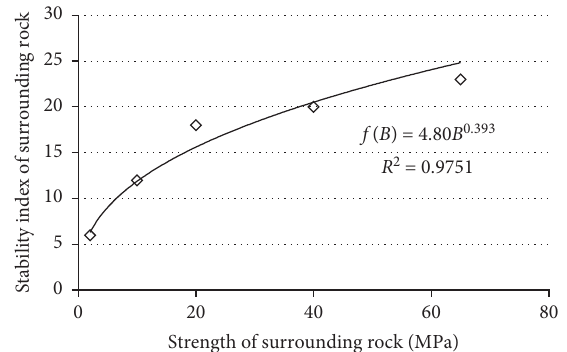
Figure 6: Fitting curve between stability index and strength of surrounding rock.